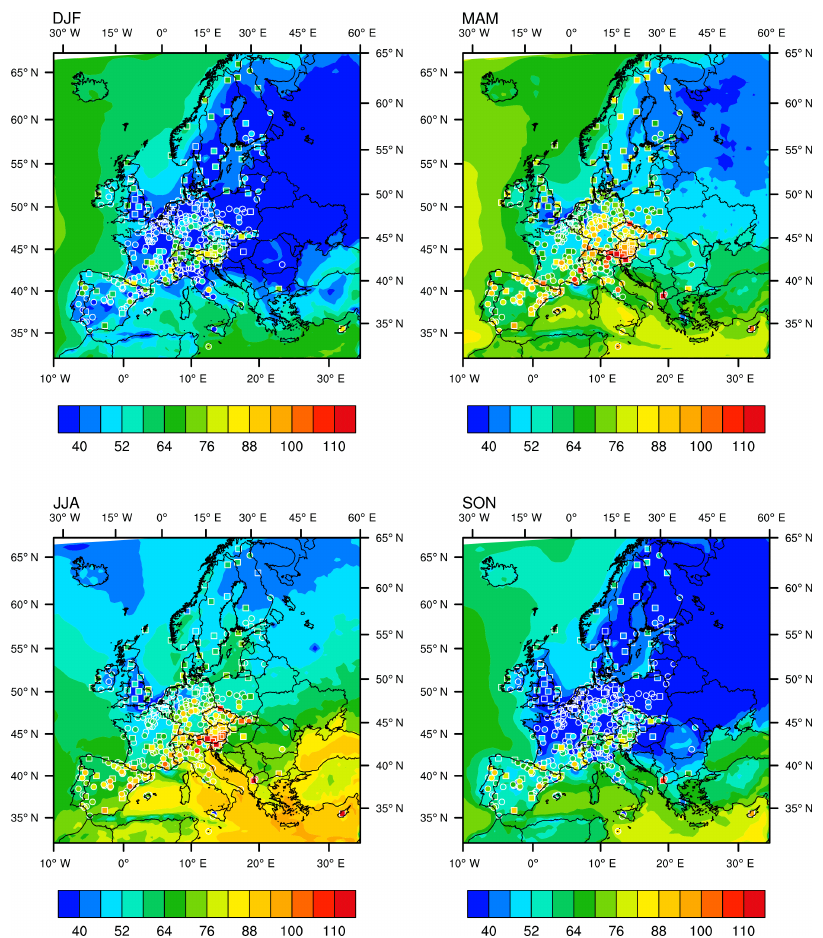
Figure 9. Seasonal average values of surface O 3 in µgm − 3 . Contours are model output from the RADM2 simulation. Filled dots represent hourly measurements at AirBase rural background stations, filled squares represent measurements at EMEP